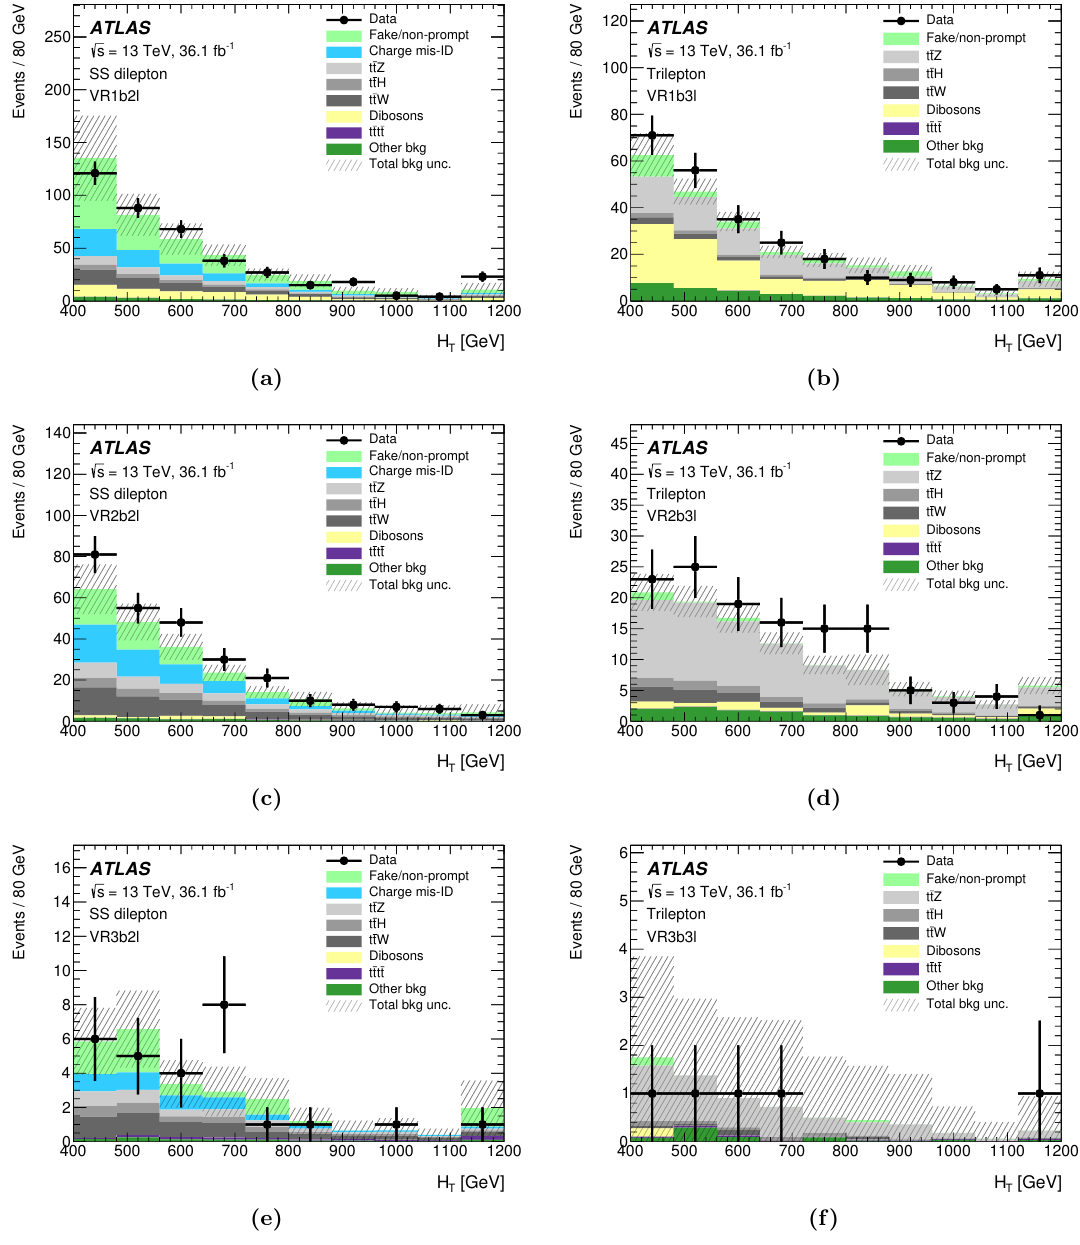
Figure 5 . Distributions of H T in each of the validation regions used for the four-top-quark and VLQ searches. The (cid:12)rst (second) column shows distributions of dilepton (trilepton) events while each row corresponds to a given b -tagged jet multiplicity. The uncertainty, shown as the hashed region, includes both the statistical and systematic uncertainties from each background